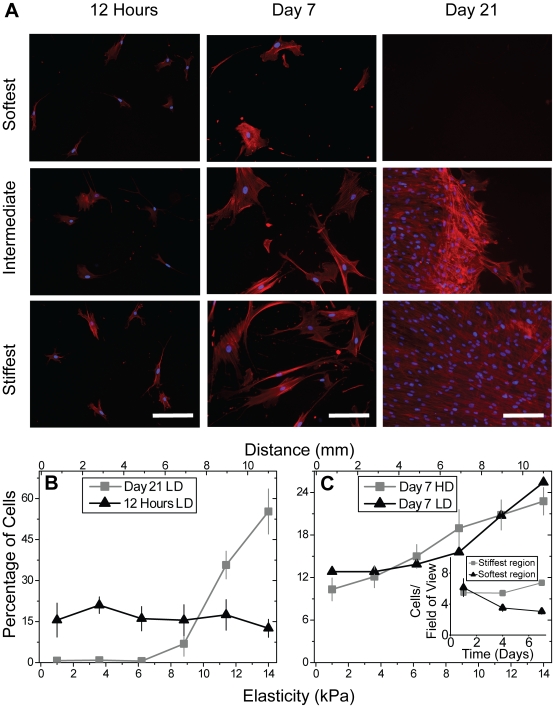
Spatial distribution of mitomycin C-treated MSCs on gradient hydrogels.(a) Images of Hoescht 33342 (blue) and phalloidin (red)-stained mitomycin C-treated MSCs plated at low density (250 cells/cm2) illustrate the change in distribution with time. After 21 days, MSCs are locally confluent in the stiffest region of the hydrogel. Scale bar is 56.5 µm. (b) At 12 hours, low density mitomycin C-treated cells were distributed evenly, while at day 21, essentially all the cells had migrated to the stiffest region of the hydrogel and formed a locally confluent layer. p<0.001 for all data comparing days 1 and 21. (c) At day 7, both low density and high (1000 cells/cm2) density cell seeding shows a 2-fold increase in cell density between the stiffest and softest regions of the hydrogel. The inset shows how the cell density changes at the stiffest versus the softest region over time. p<10−2 for both densities comparing cells at the center and edge.